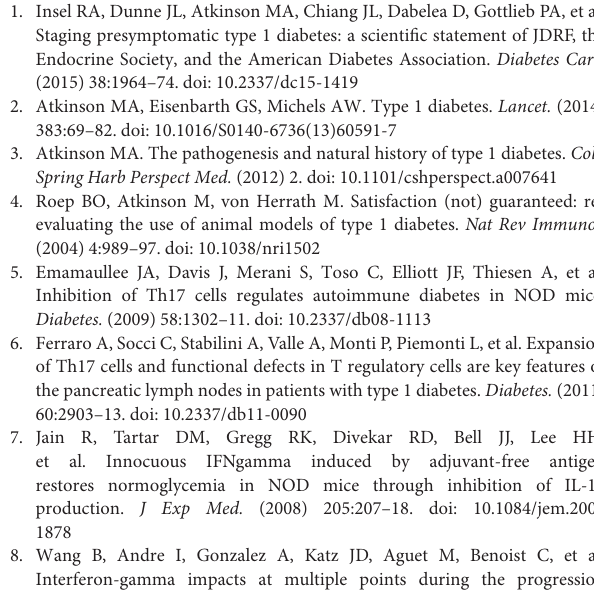
Supplementary Figure 1 | Dendritic cell antibody isotypes and controls used in flow cytometry. Single cell suspensions of splenocytes were isolated and grown in vitro . Splenocytes were analyzed by flow cytometry to identify dendritic cells using